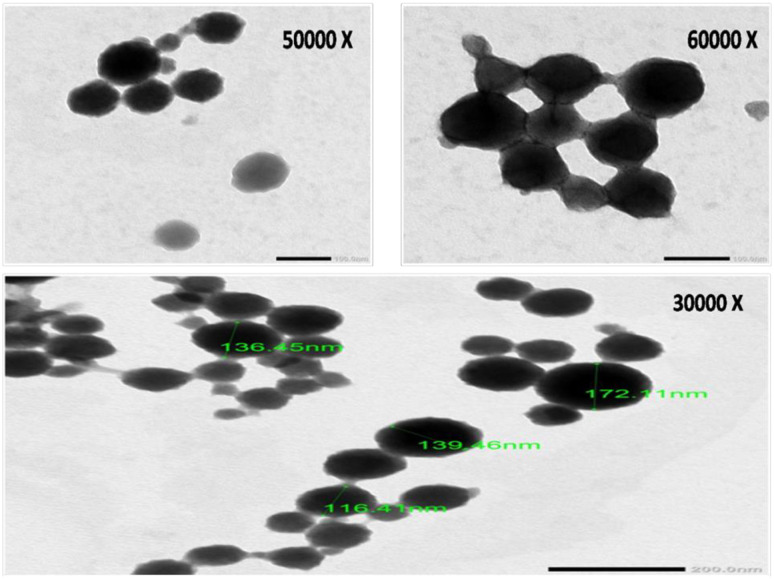
TEM images of ipriflavone loaded nanoparticles (IP-Np) at different magnifications.Green lines illustrate particle size (nm).